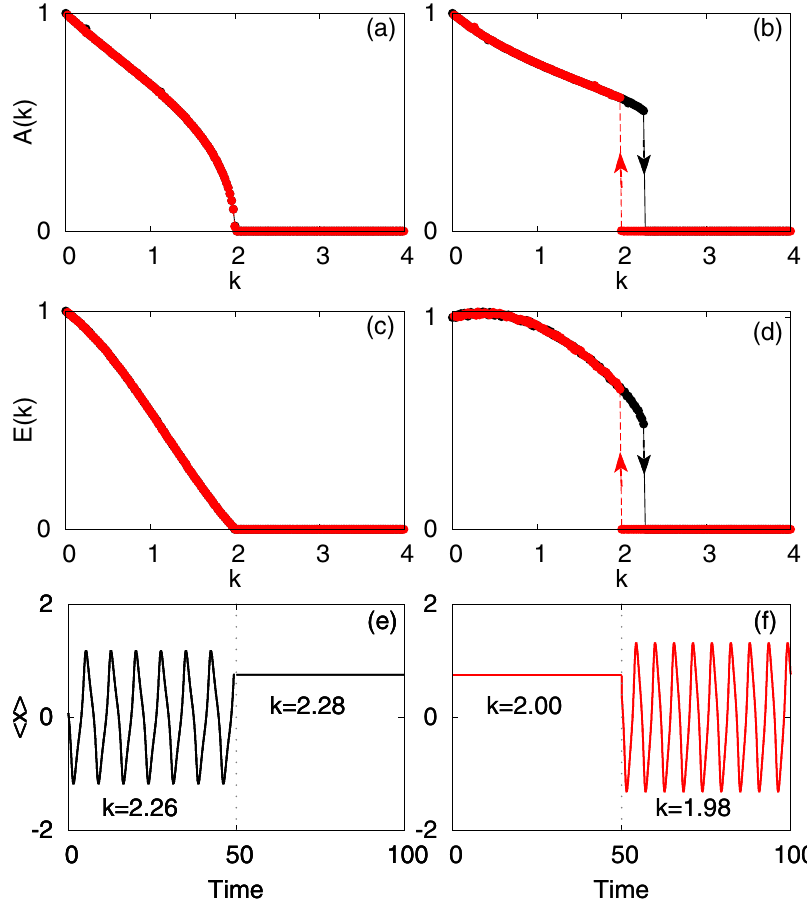
Figure 1. The transition from an oscillatory state to a quenched oscillation state of the coupled VdP oscillators is shown. Under the variation of the coupling strength, k both forward (black) and backward (red) continuations of the normalized amplitude, A ( k ), and normalized mean incoherent energy, E ( k ), are shown in ( a ) and ( c ) for b = 1.0 and ( b ) and ( d ) for b = 2.0. Time–series of the mean–field near the transition point for ( e ) forward and ( f ) backward continuations of Eq. (1) for b = 2.0. The other parameters are Q = 0.5 and N = 100.